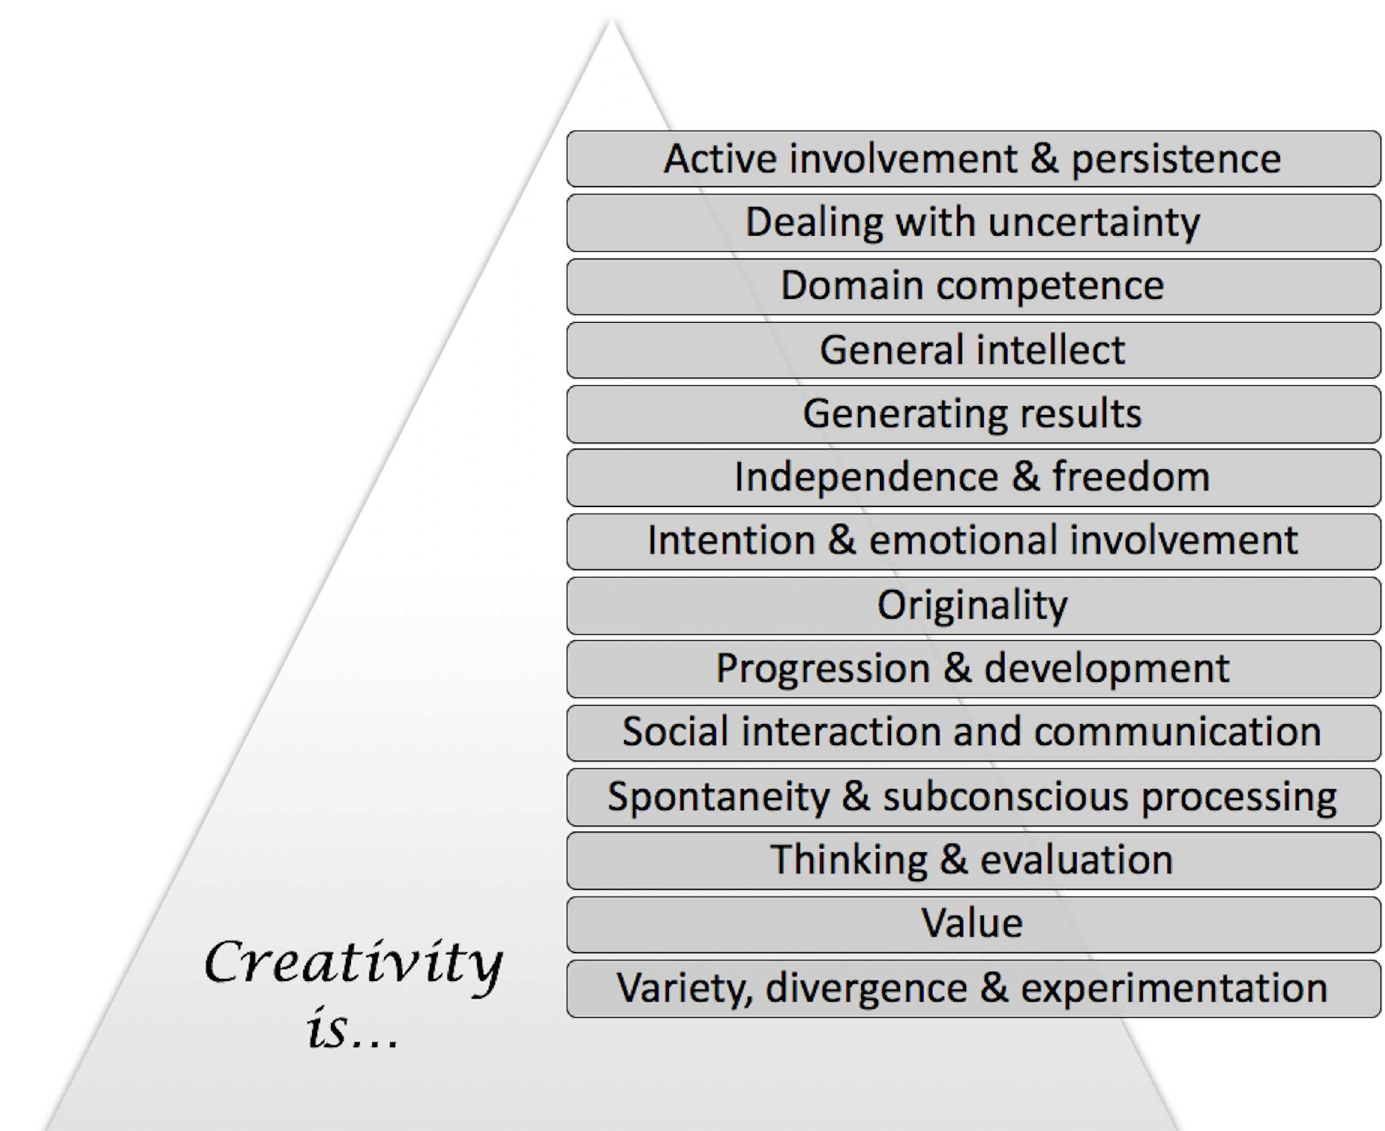
Fig 7. The fourteen key components of creativityidentified through an analysis of the word